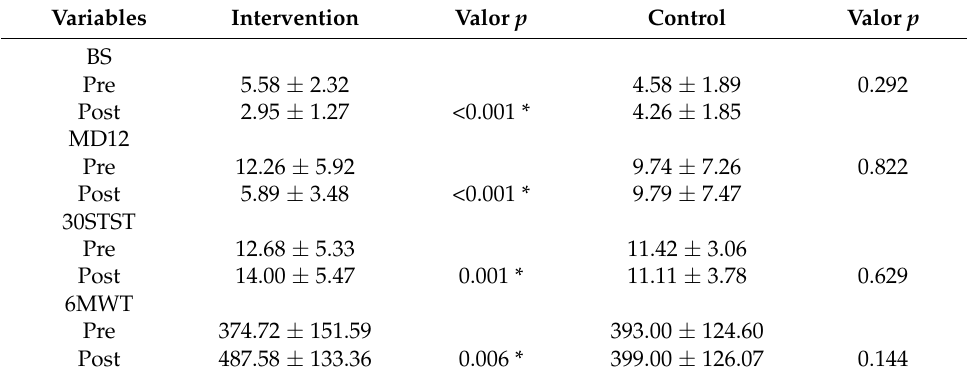
Table 2. Within-Group Differences.